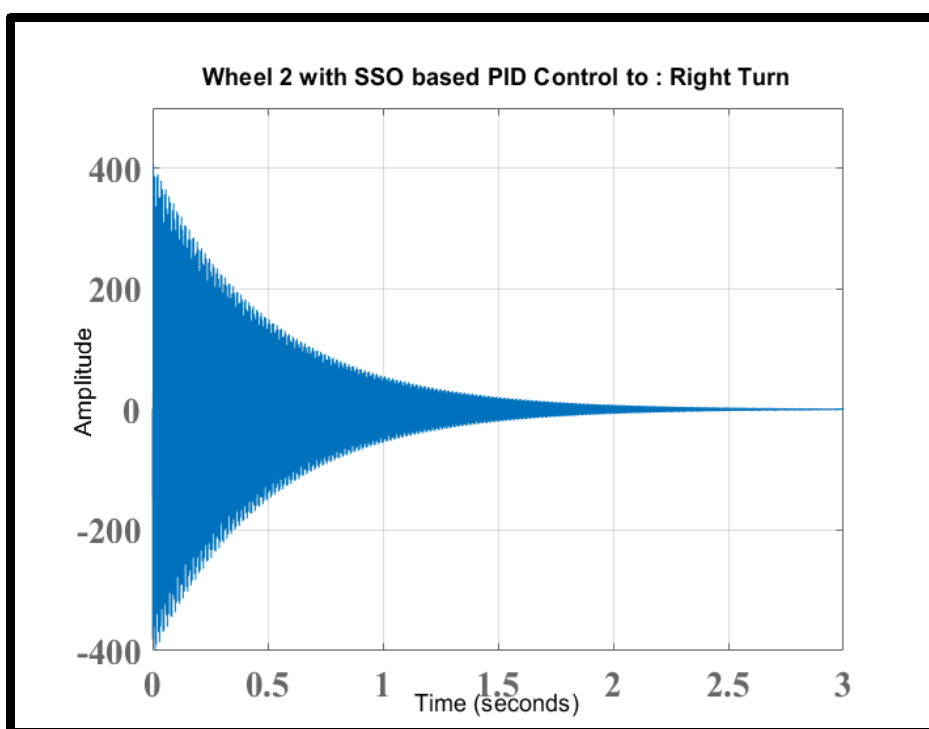
Figure 13. Simulation of wheel 1 turning right when V r > V L .